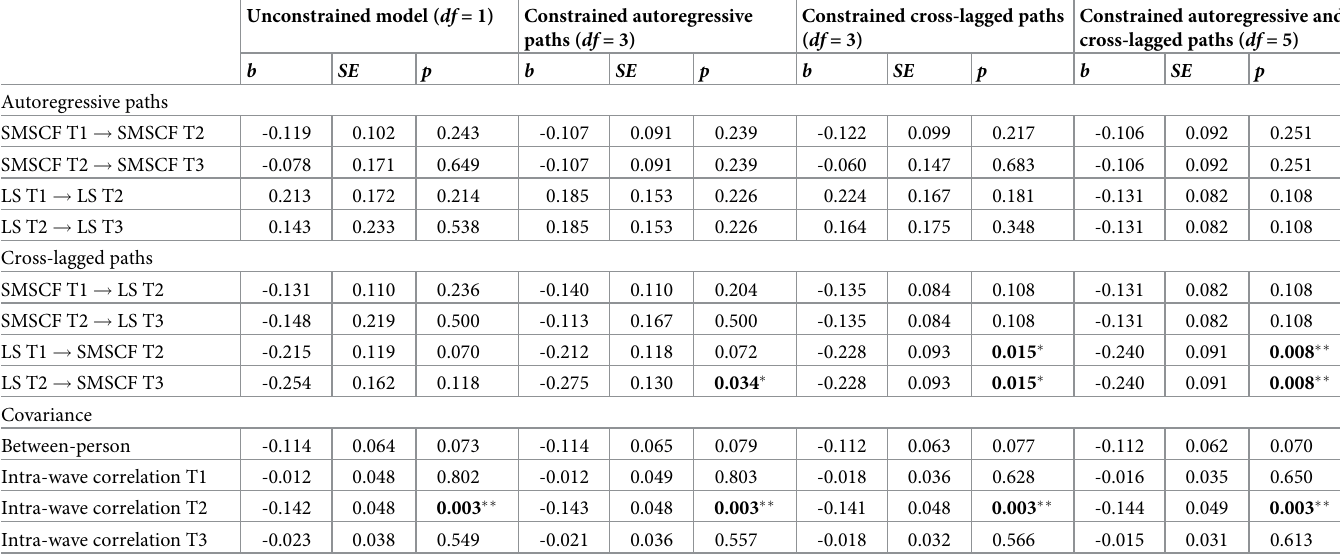
Table 8. Reciprocal relationships between social media self-control failure and life